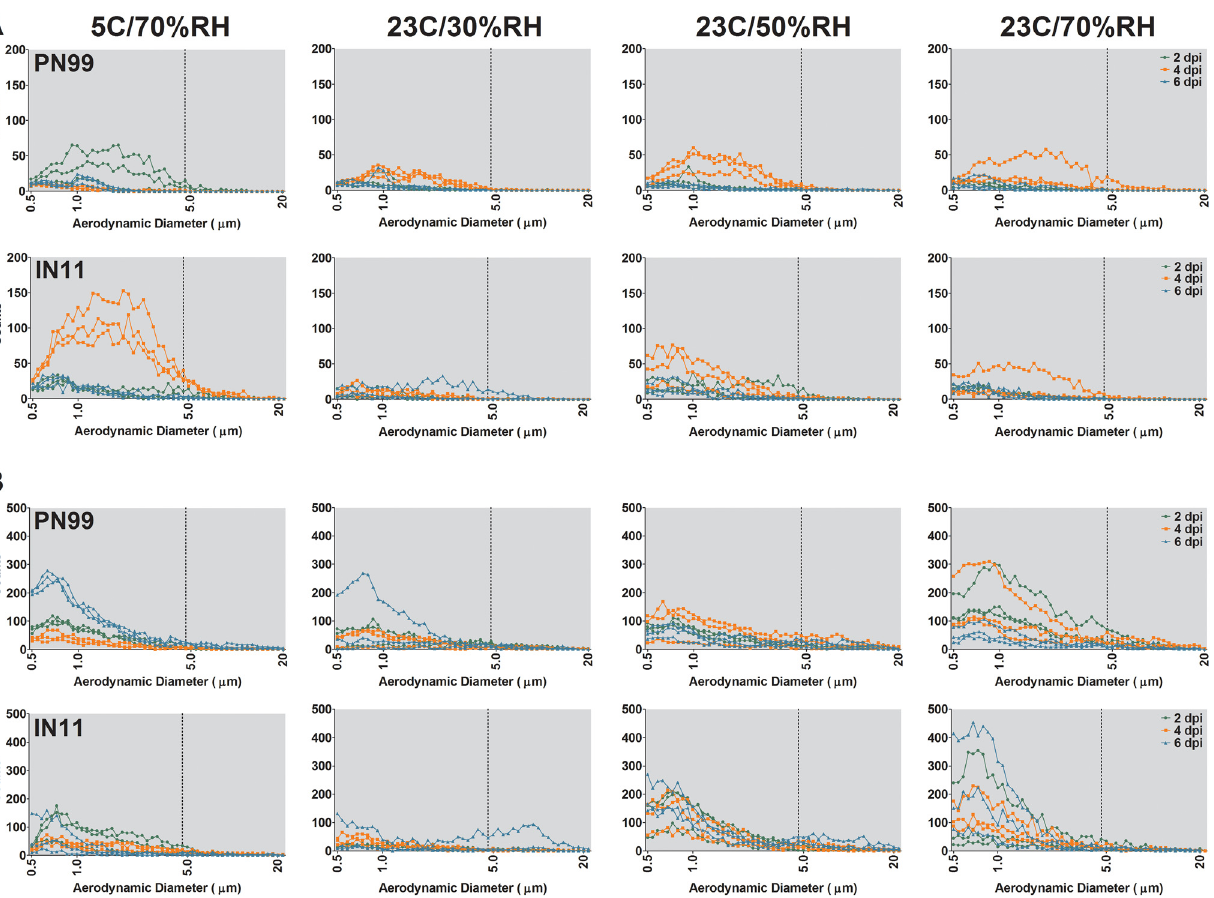
Fig 3. Size distribution of aerosols exhaled from influenza virus infected ferrets. Aerosol particle counts were measured for individual ferrets, n = 3, collected during 15 minutes of normal breathing (A) or 5 minutes of sneezing stimulation (B) on 2, 4 and 6 dpi. Ferrets were housed under controlled environmental conditions as indicated. Aerosol particles within the range of 0.5 μ m to 20 μ m in size are shown with key sizes noted on the x axis and a broken vertical line denoting the respirable particle fraction at < 5 μ m.